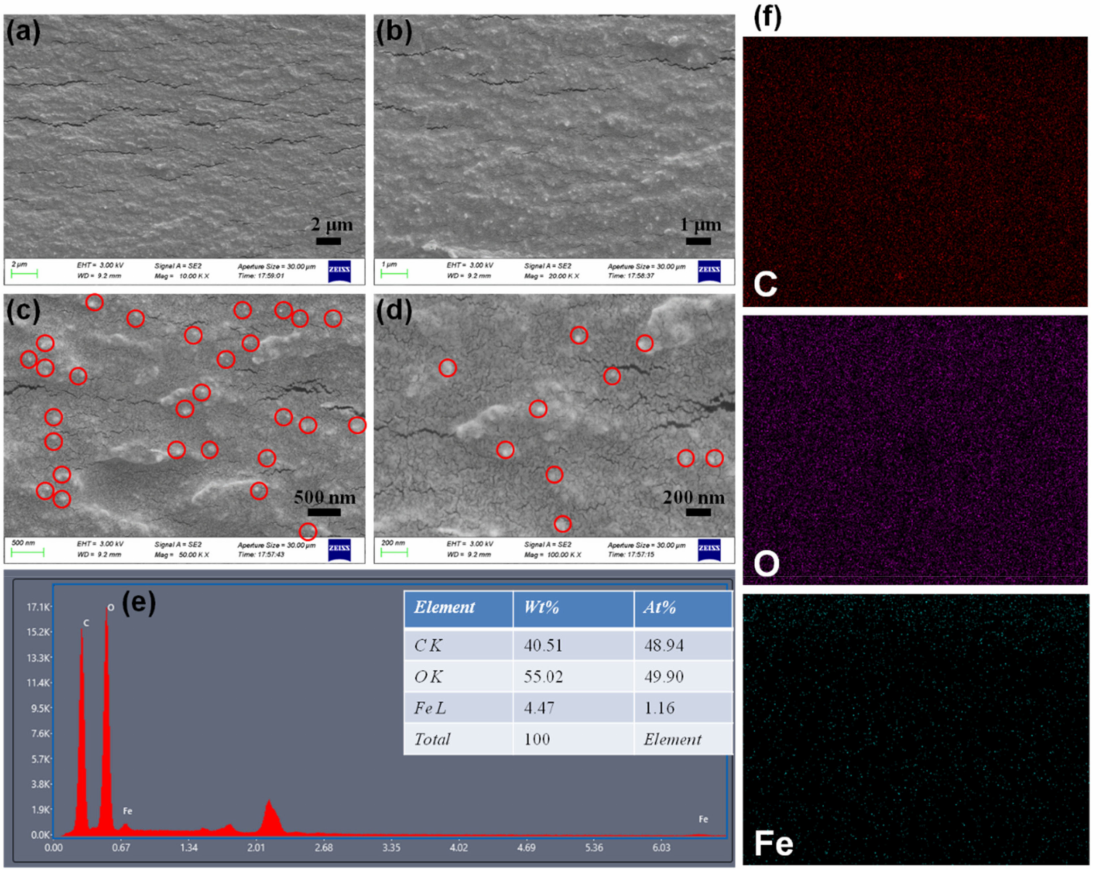
Figure 1. ( a – d ) Cross-sectional SEM images of M(Fe)CCF3 under different magnifications; ( e ) EDS spectrum of M(Fe)CCF3; ( f ) Elemental mapping images of M(Fe)CCF3 for carbon, oxygen and iron. The current methods for the synthesis of MIL-88A(Fe) are mostly hydrothermal or solvothermal, both of which require high temperature or organic solvents [32]. Therefore, a simple, low-temperature and green preparation method for MIL-88A(Fe) deserves attention, which not only reduces energy consumption but also facilitates the development and appli- cation of MIL-88A(Fe). In this work, a green, simple and room temperature preparation method for MIL-88A(Fe) was used, obtained by reacting an aqueous solution of FeCl 3 with an ethanolic solution of fumaric acid [33]. As shown in Figure 2, pure MIL-88A(Fe) shows a homogeneous and well-crystallized spindle shape with an average width of 245 nm and an average length of 650 nm. It is noteworthy that the size of MIL-88A(Fe) particles in M(Fe)CCF was much smaller than that of directly synthesized MIL-88A(Fe), and the size of MIL-88A(Fe) also changed its morphology from spindle-shaped to spherical nanoparticles. This is attributed to the “nano-confinement” effect of the nanopores in cellulose hydrogel, which facilitates the preparation of small, uniformly distributed MIL-88A(Fe)